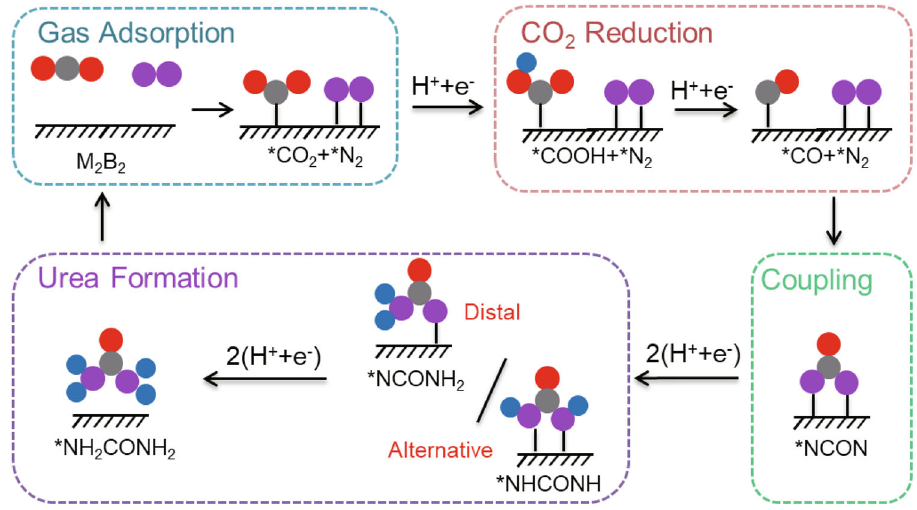
Fig. 2 Reaction mechanism. Schematic diagram of the mechanism of urea production through the electrochemical coupling of N 2 and CO 2 . The gray, red, pink, and blue balls represent C, O, N, and H atoms, respectively.